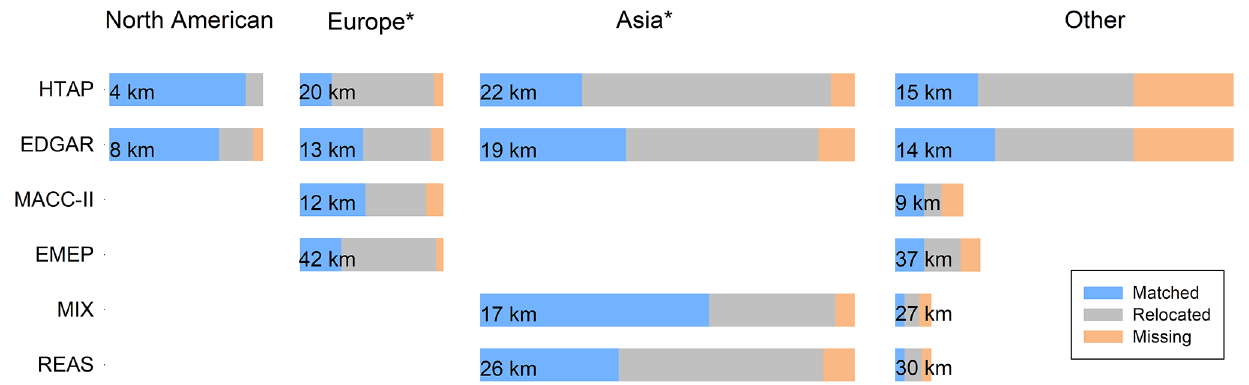
Figure 7. Comparison of locations of anthropogenic large point sources detected by OMI with those in bottom-up inventories. The length of the bar denotes the number of sources. The blue bar denotes the sources with the same location in both the bottom-up and the OMI- based inventory (matched). The grey bar denotes the sources with location mismatches between the bottom-up and OMI-based inventories (relocated). The red bar denotes the OMI-based sources missing from the bottom-up inventory (missing). The numbers denote the average distance between OMI-detected locations and those in the bottom-up inventory for both relocated and matched sources. ∗ Sources from countries that are only partly covered by European or Asian inventory, like Russia, Turkmenistan, Uzbekistan, and Kaza- khstan, are categorized as other to remain consistent with